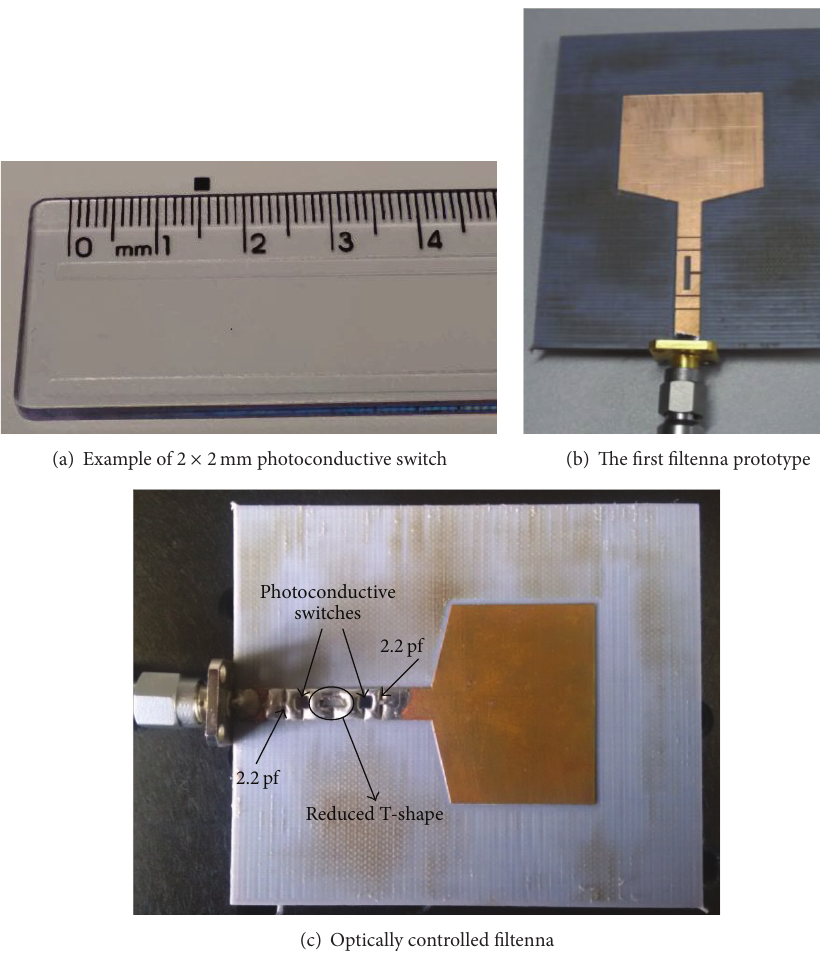
Figure 11: Optically controlled reconfigurable filtenna prototype.